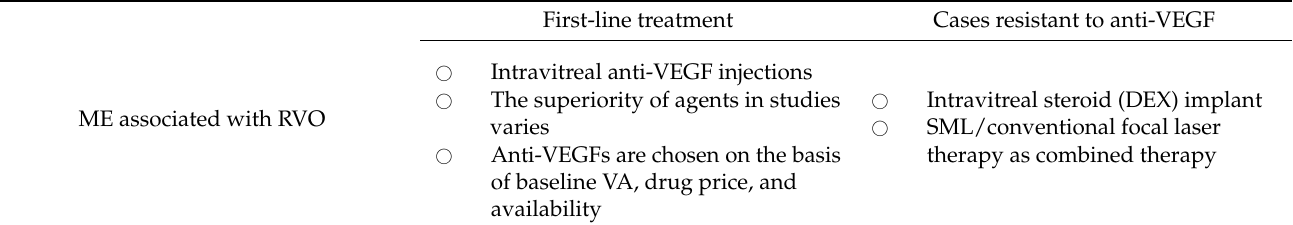
Table 2. Summary of treatments for ME associated with